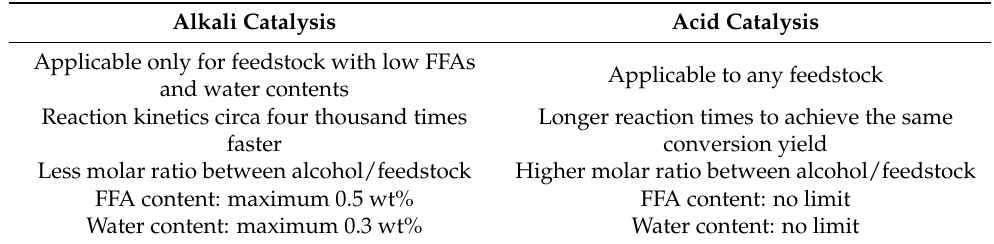
Table 4. Main characteristics of the alkali and acid catalysis for biodiesel production. Alkali Catalysis